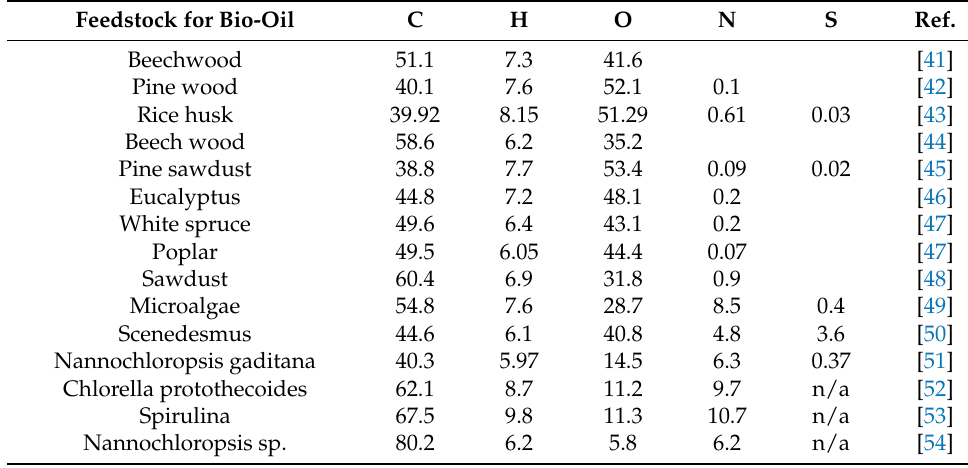
Table 2. Feedstock composition updated from